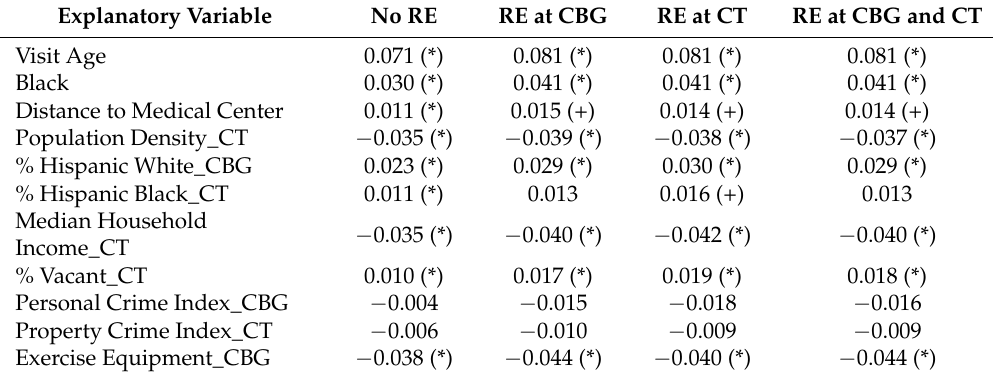
Table 9. Standardized coefficient estimates from the spatial scale (SS) forward stagewise model of BMI z-scores with no random effect (RE) in comparison to standardized coefficient estimates from three mixed models with a RE at the census block group (CBG), the census tract (CT), and the CBG and CT. The mixed models were fit using the covariates that were chosen by the SS stagewise algorithm. The horizontal dashed line separates the individual-level variables and the neighborhood-level variables considered at multiple spatial scales.